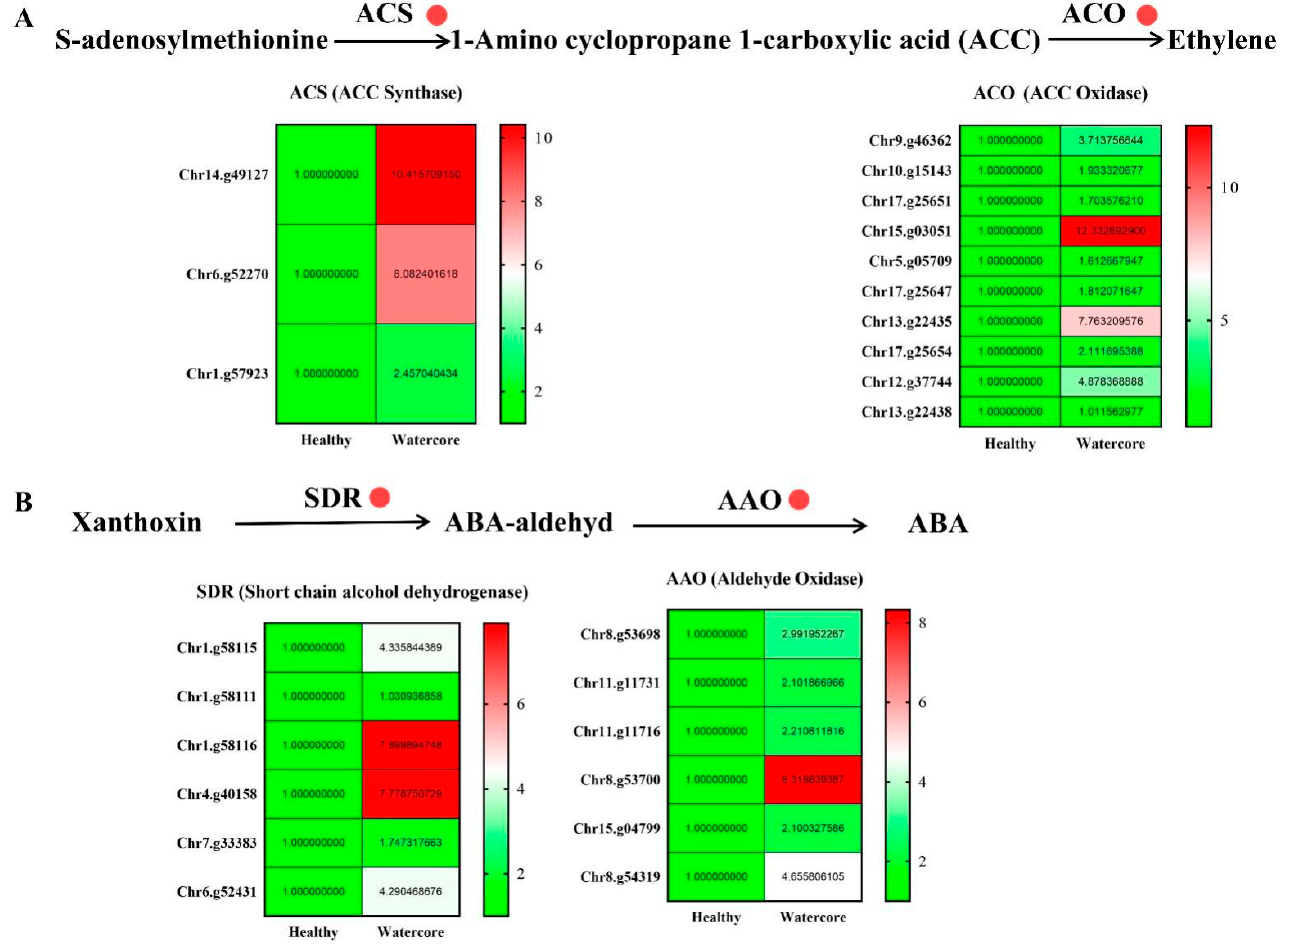
Figure 5. Analysis of ethylene ( A ) and abscisic acid ( B ) metabolism-related gene expression in watercore.